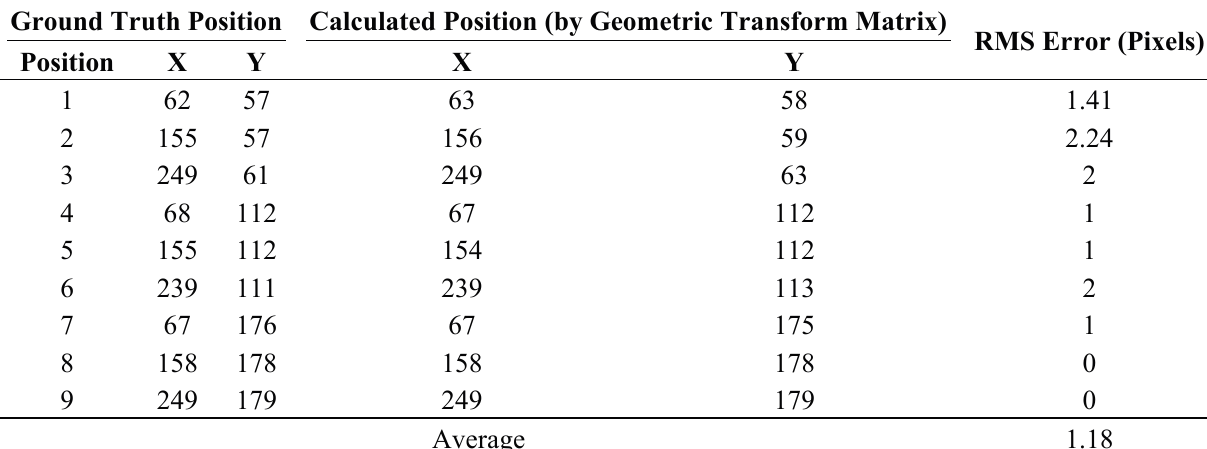
Table 2. Accuracy of geometric transform between visible-light and thermal images. Ground Truth Position Calculated Position (by Geometric Transform Matrix)